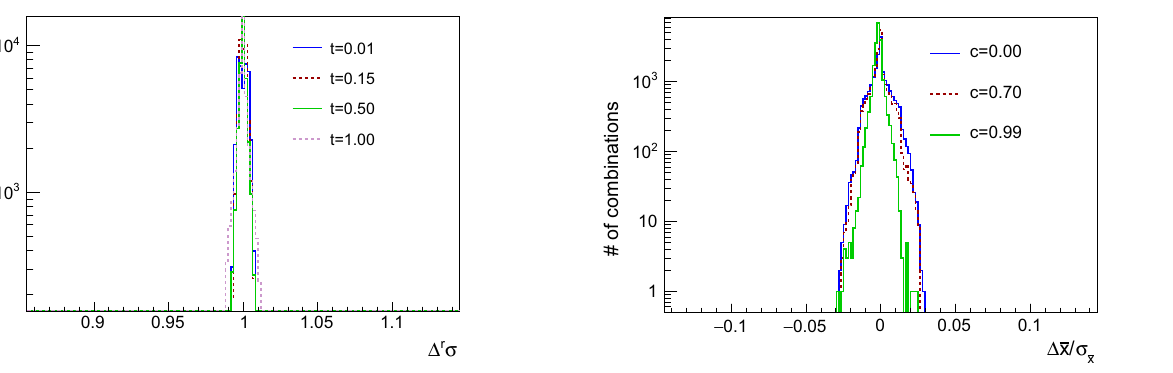
Fig. 5 Difference between the combined results ¯ x from the method proposed here and using a direct likelihood combination relative to the total uncertainty on ¯ x . The distribution is shown for different values of the correlation c between the systematic uncertainties of both pseudo-- measurements